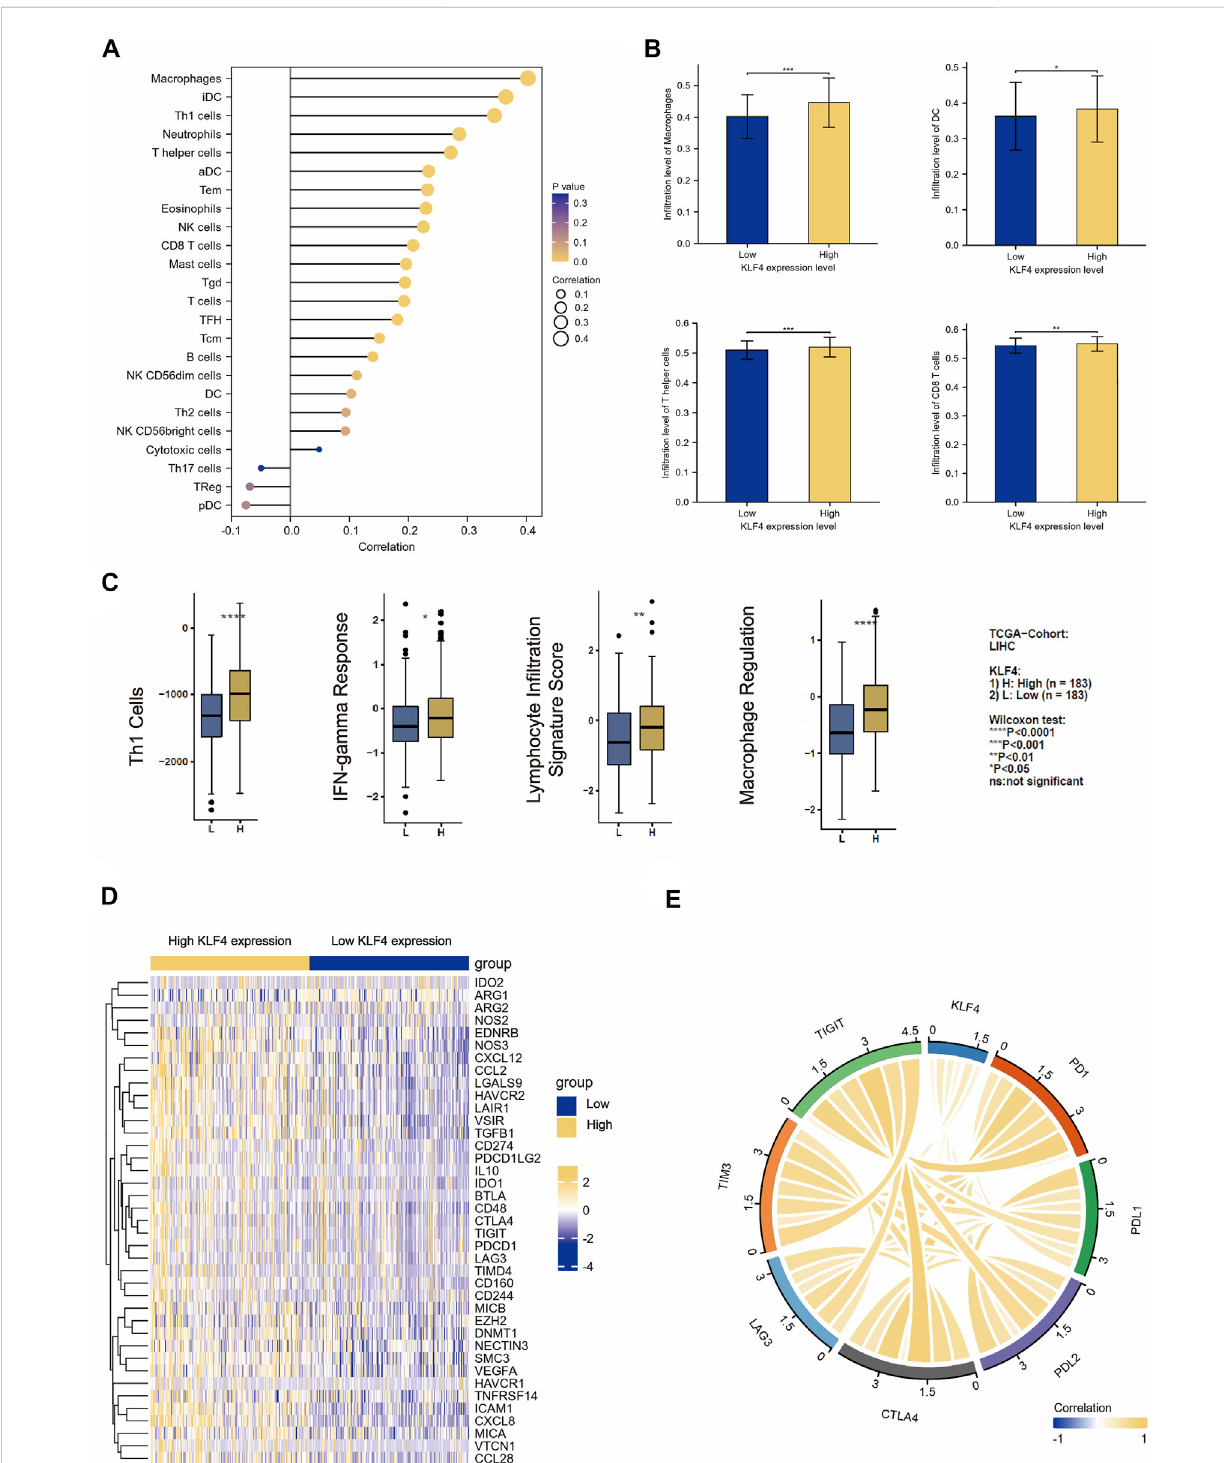
FIGURE 5 Immune cell in fi ltration analysis (A) The correlation between the level of expressed KLF4 and the abundance of 24 types of immune cells (B) The in fi ltration level of macrophage, DC, CD8+T cells, and T helper cells in the KLF4 low-/high-expression group (C) The correlation between the level of expressed KLF4 and the immune scores of Th1 cells, lymphocyte in fi ltration signature score, IFN-gamma response, and macrophage regulation (D) Differentially immune checkpoint between low- and high- KLF4 repression groups (E) The correlation between classical immune checkpoints and the KLF4 expression